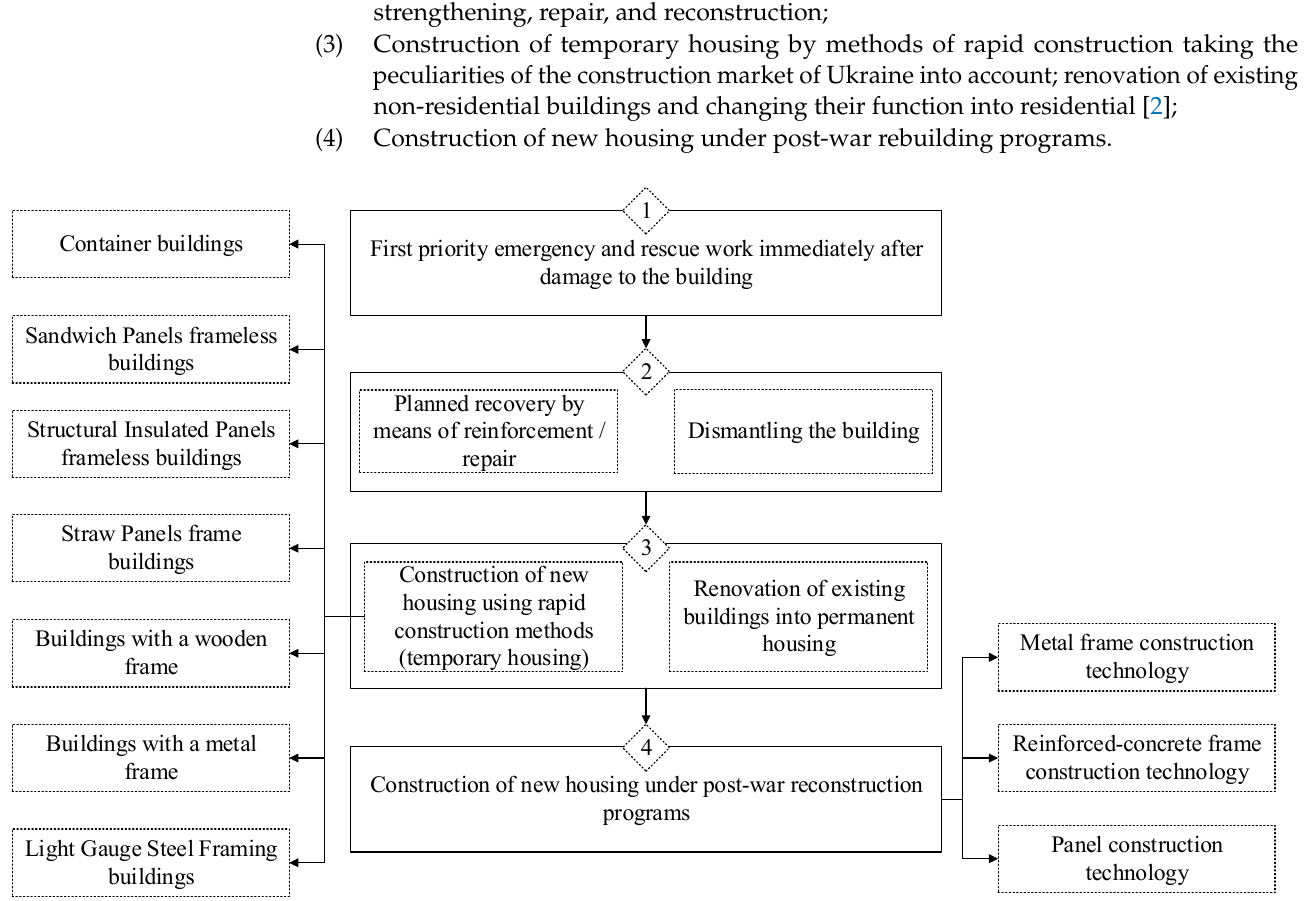
Figure 1. The main areas of problems facing the building stock of Ukraine as a result of military